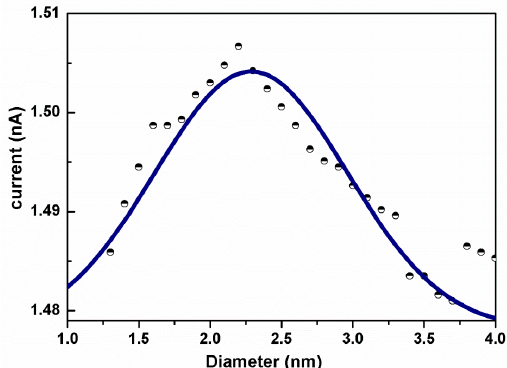
Figure 3. The Gaussian fit data solid line is the size distribution of AlN nanoparticles using a quadrupole mass filter.